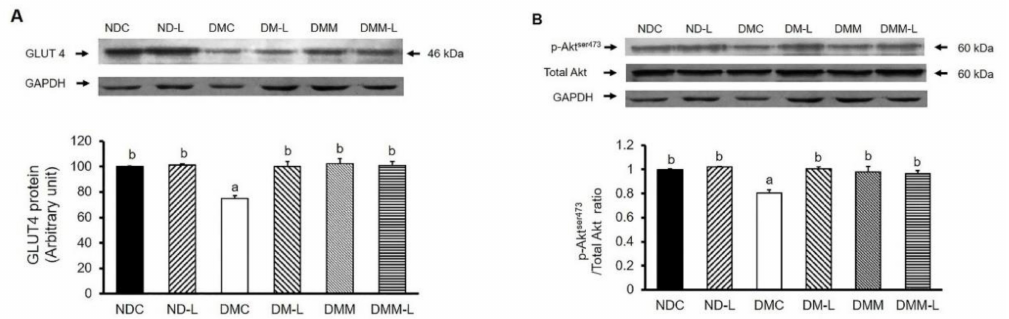
Figure 3. E ff ects of L. paracasei HII01 on Western blotting of insulin-stimulated glucose uptake marker proteins ( A ) GLUT4 protein ( B ) pAkt ser473 / Total Akt ratio in experimental groups. NDC, normal control rats; ND-L, normal control rats supplemented with L. paracasei HII01 (10 8 CFU / day); DMC, diabetic rats